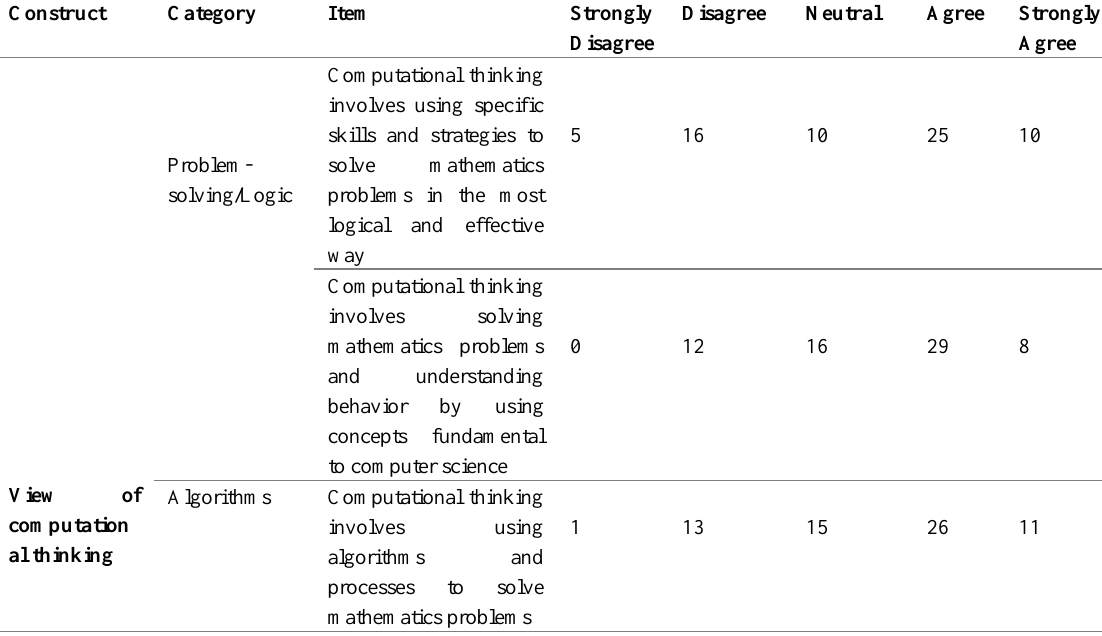
Table 4: Distribution of responses to the